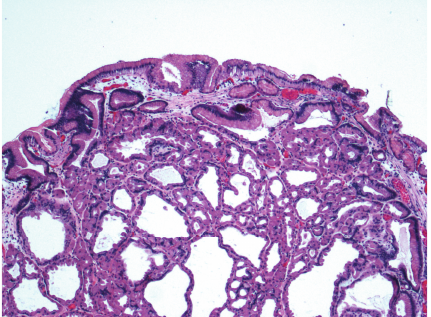
Figure 2: Fundic gland polyp, Hematoxylin and Eosin stain, 40x magnification.